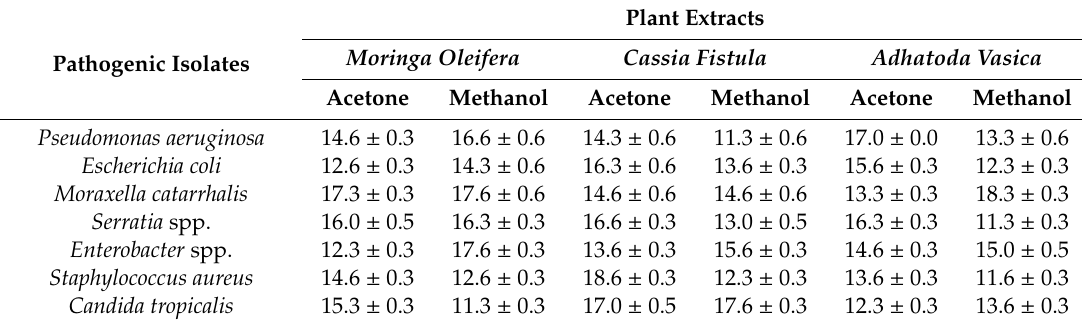
Antimicrobial activity of Moringa oleifera , Cassia fistula , and Adhatoda vasica against isolated